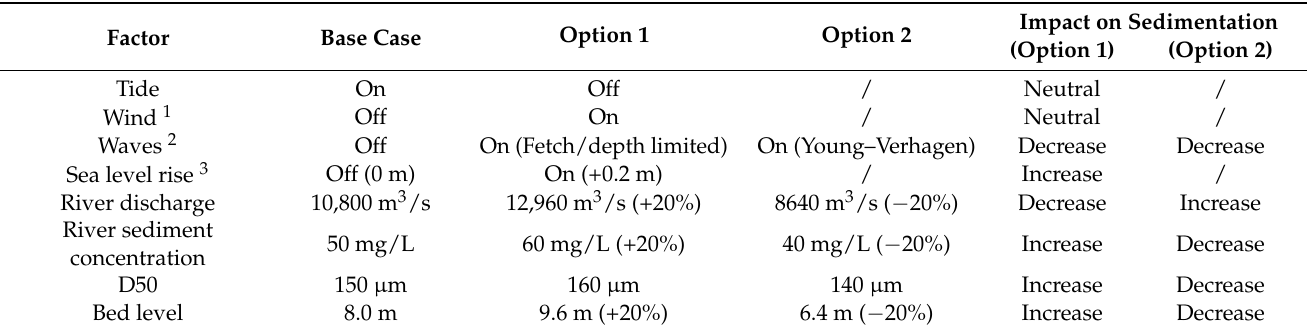
Table 2. Summary of the factor settings in different scenarios for L2a and their impacts on the sedimentation.